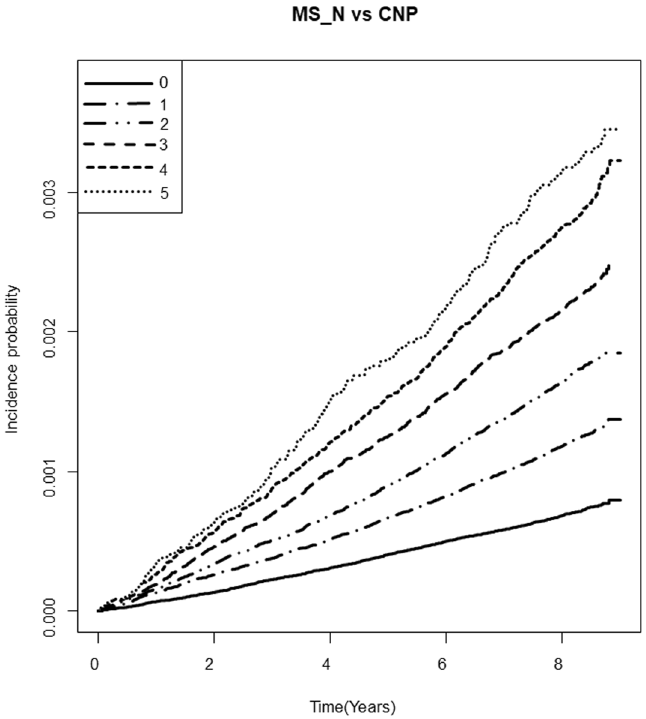
Figure 1. Kaplan–Meier curves of incidence probability of ocular motor cranial nerve palsy (CNP) up to 8 years according to the number of metabolic syndrome (MetS) components. Having more MetS components was associated with an increased risk of developing ocular motor CNP during the follow-up period compared to having no MetS component (log-rank test p > 0.0001).